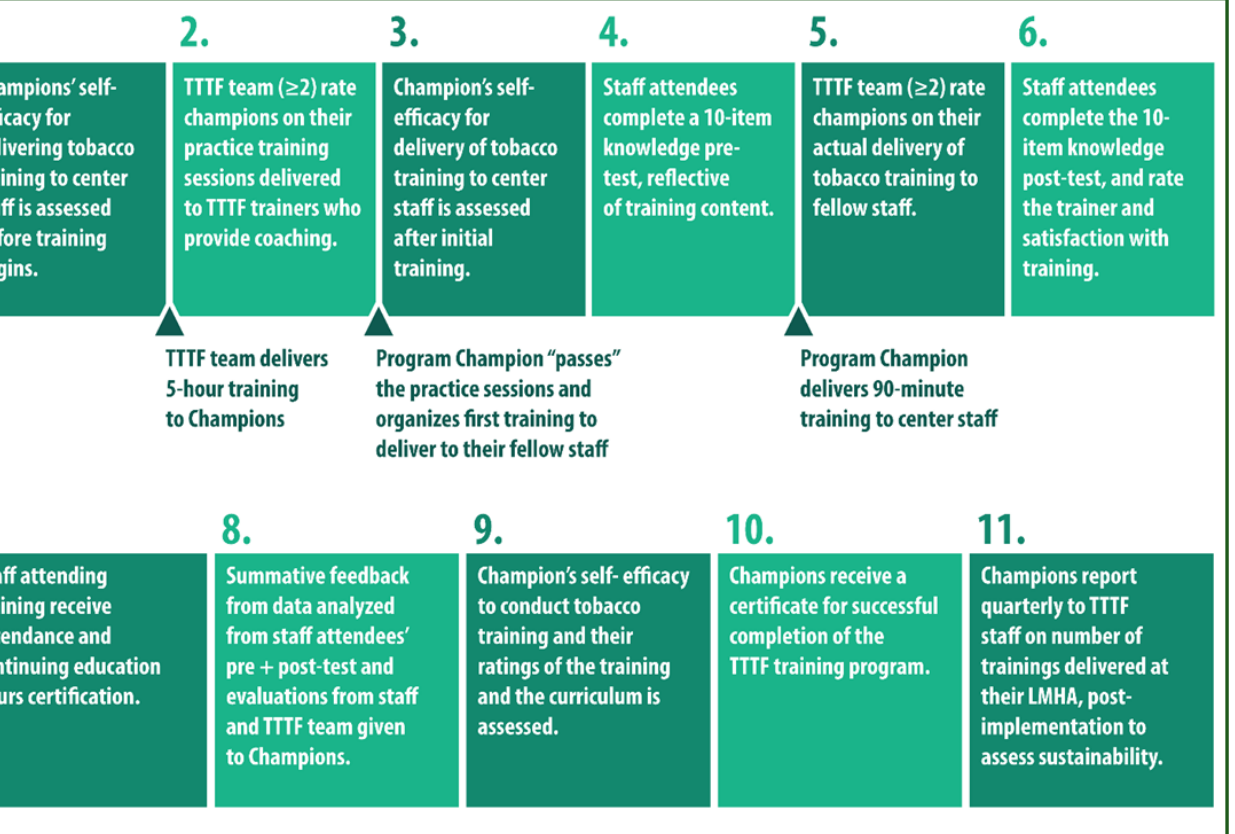
Figure 1. Infographic summarizing the steps involved in implementing the Taking Texas Tobacco- Free (TTTF) “Train-the-Trainer” program. Main events are marked underneath in between some steps. Reprinted/adapted with permission from Ref [18]. 2021, L. R. Reitzel on behalf of all coau- thors.